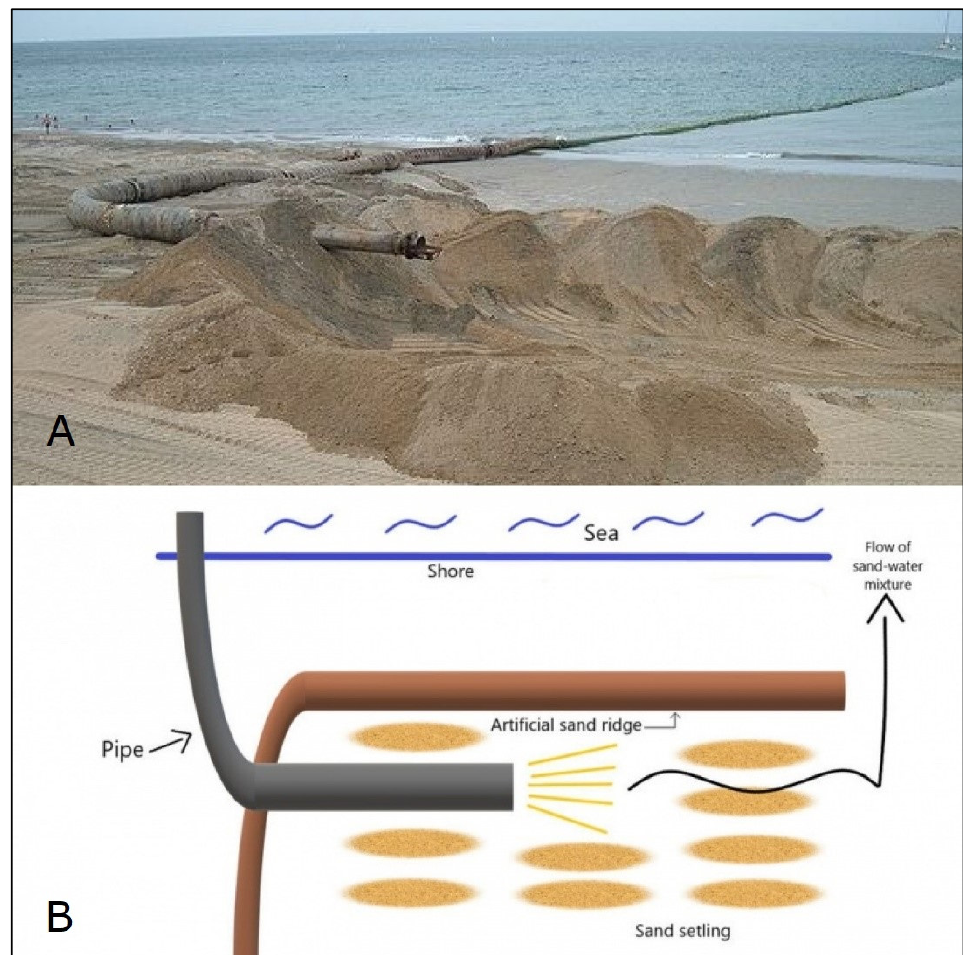
Figure 7. Sand pumping system in a photo ( A ) and schematised diagram ( B ). The pipe is brought to the beach and placed within an artificial ridge. This pipe releases a mixture of sand and water (approximately in a 1/5 proportion) that, thanks to the ridge, settles most of the sediment before reaching the shore.